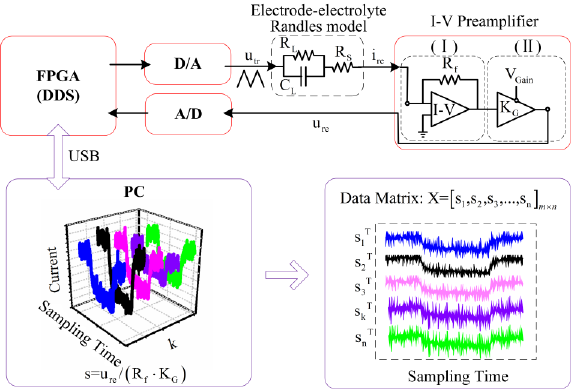
Figure 1. Schematic diagram of the impedance measurement system. FPGA: Field-programmable gate array; DDS: Direct digital synthesizer; D/A: Digital-to-analog converter; A/D: Analog-to-digital converter; (І): Current-to-voltage converter; (II): Voltage amplifier. PC: Personal computer.